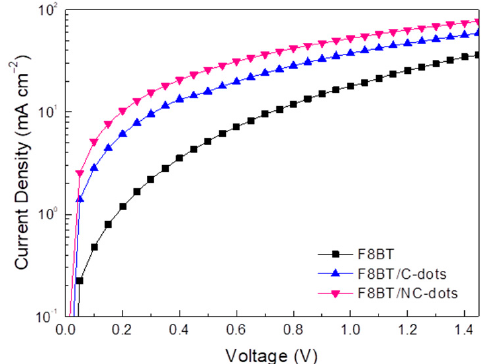
Figure 7. Electron-only current densities of diodes with the structure ITO/F8BT/Al without and with C-dots and NC-dots at the cathode side of the device.